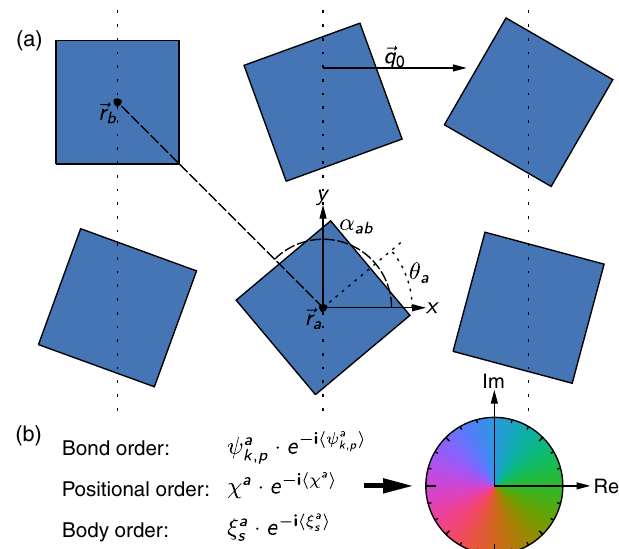
FIG. 2. (a) Pictorial definitions of ~r map order parameters to a color wheel for visualization. Each order parameter is rotated by its average in a given frame so that the average order parameter is colored green. The color wheel is the color part of the cubehelix [38] color map at constant